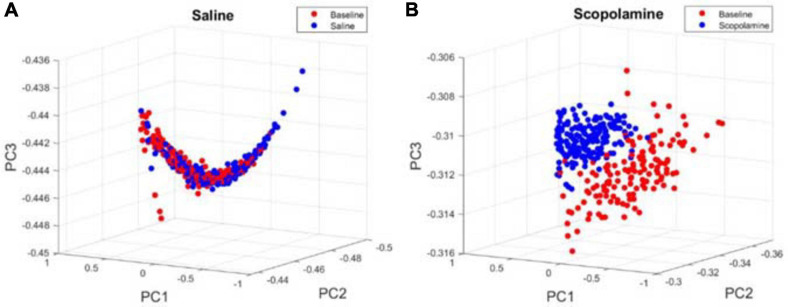
Examples of principal component space for the results of the spike-train epochs after applying unsupervised autoencoder. Each circle represents a 2.5 s data segment of recordings at baseline (red) or (A) saline/(B) scopolamine (blue).